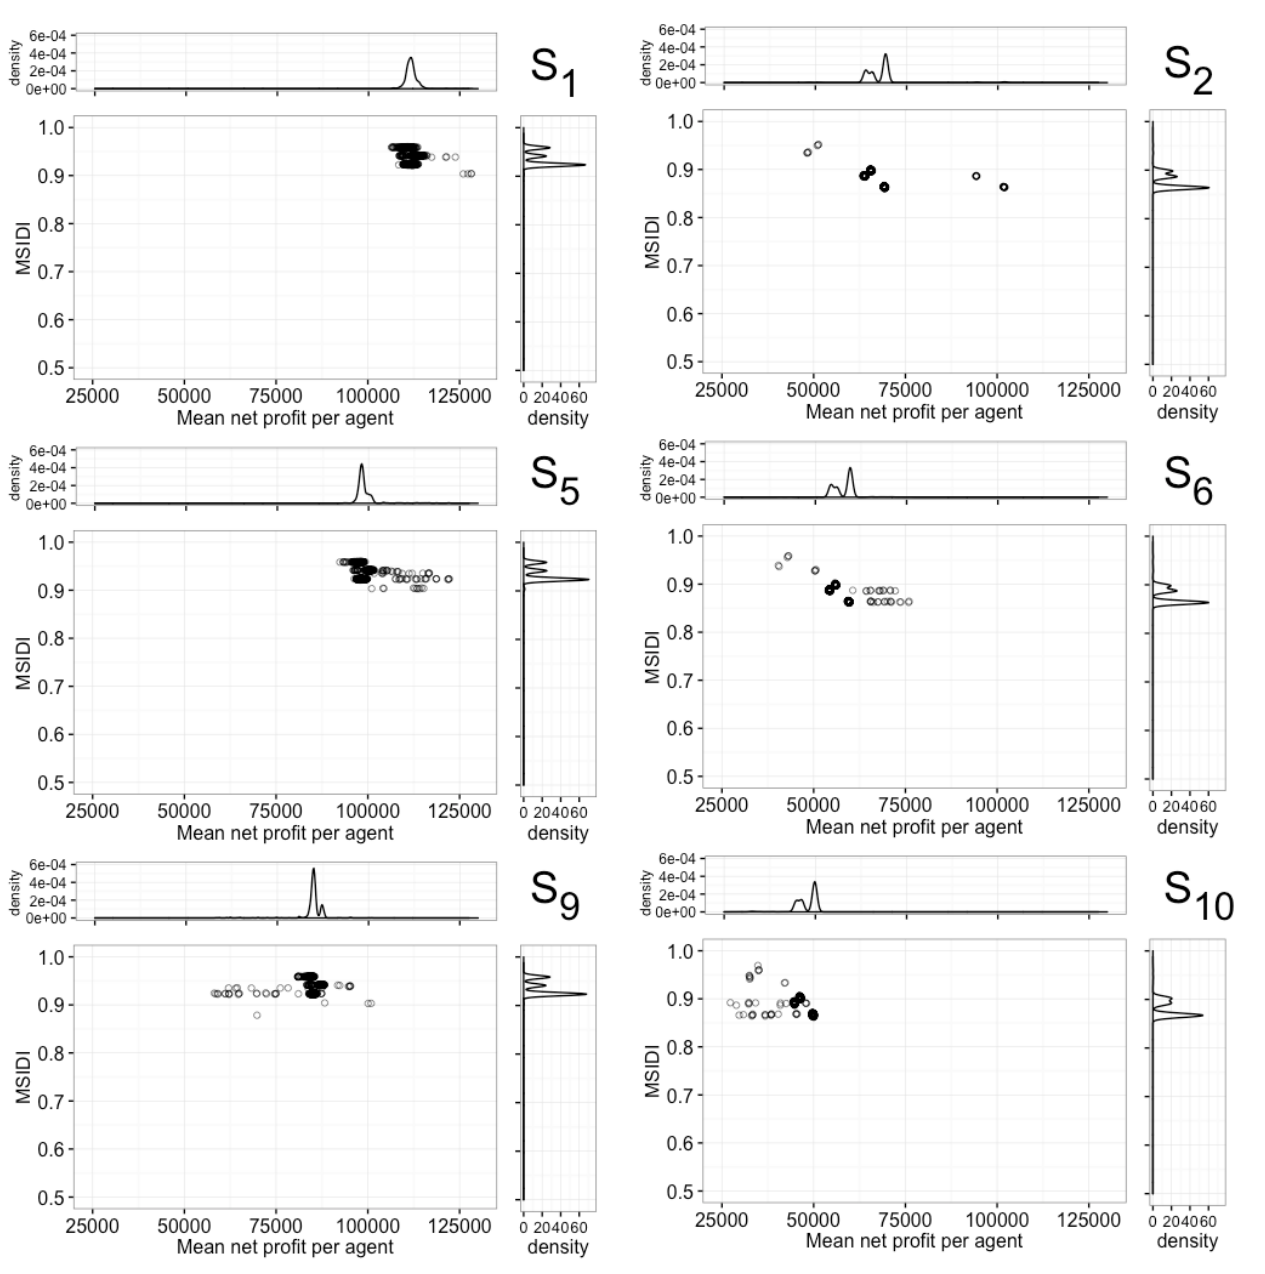
Fig. 6 . Stability landscapes for scenarios that include status quo land use policy (no switchgrass market). Scenarios in the left column are affected by the baseline perturbation regime; scenarios in the right column are affected by the alternative. Insurance reimbursement rates range from top to bottom by row at 100%, 75%, and 50%, respectively. Landscape configuration (basin topography) is affected by a change in perturbation severity, while changes in coping capacity result in similarly shaped density curves that shift position along the axes. (MSIDI: Modified Simpson Diversity